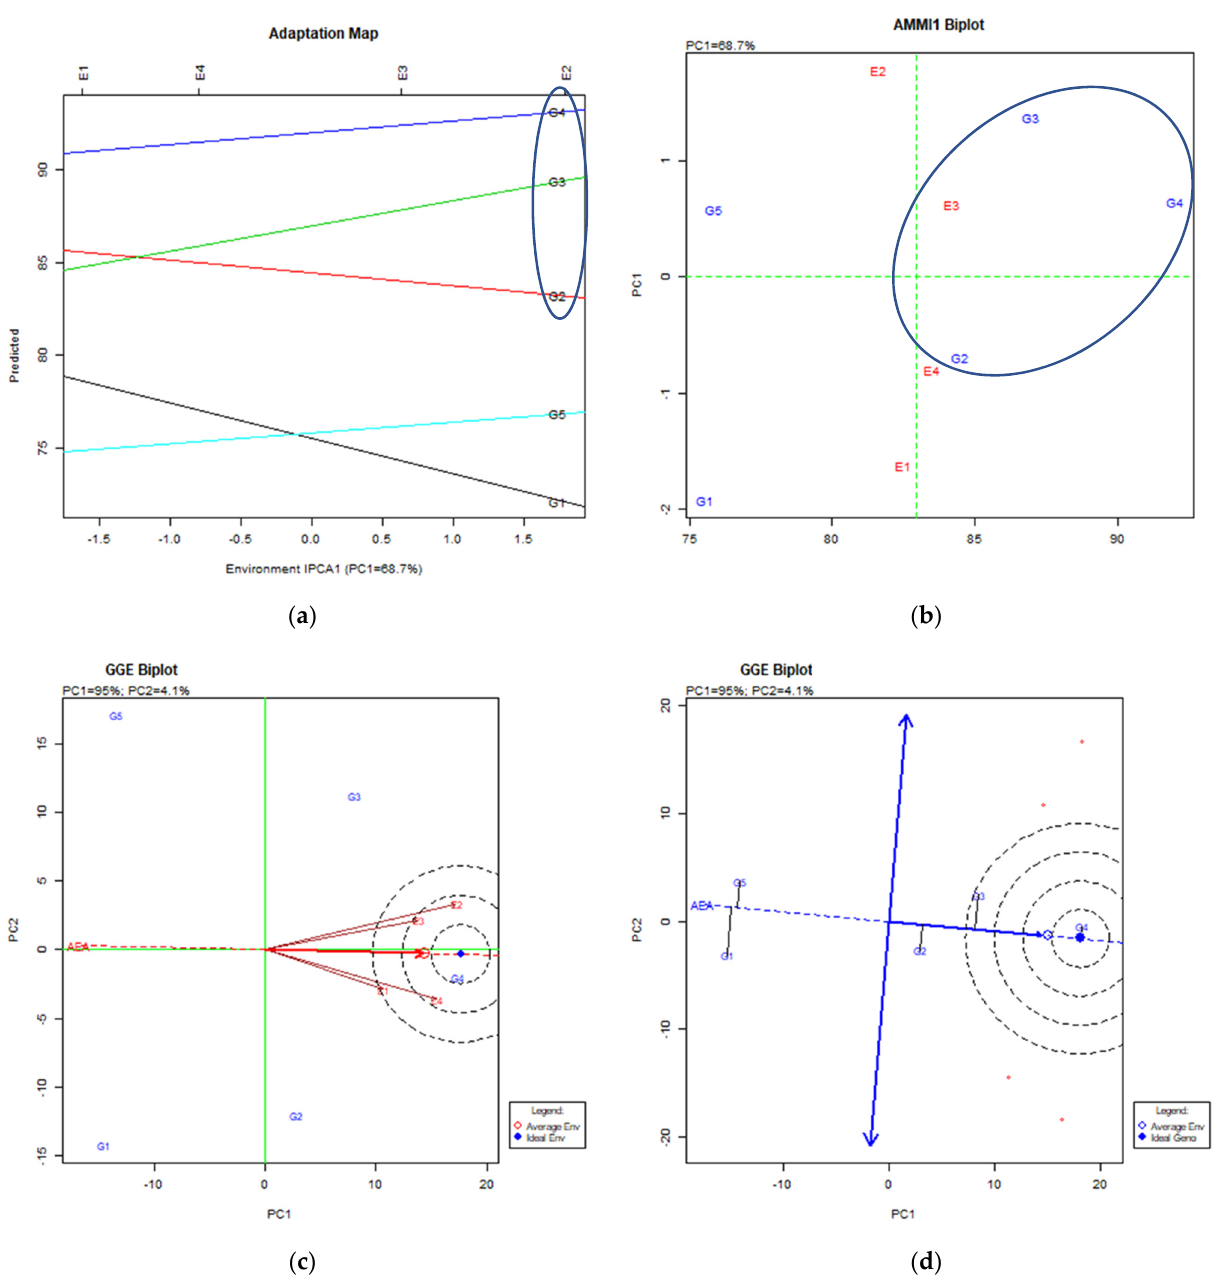
Figure 11. Stability analysis for plant height (cm) based on: ( a ) the adaptation map where the X-axis (PC1) visualizes the stability of cultivars over environments and the Y-axis—the performance of cultivars for the trait; ( b ) the AMMI1 biplot where the Y-axis is the one visualizing the trait performance and the X-axis (PC1) visualizes the stability of cultivars over environments; ( c ) the GGE biplot for environments depicting the stability of the environments over years via the placement as near as possible to the ideal and average environment; ( d ) the GGE biplot for cultivars depicting the stability of the cultivars over environments where the productive cultivars are those to the right on the AEA vector and the stable ones are those which are as close to the AEA axis as possible.